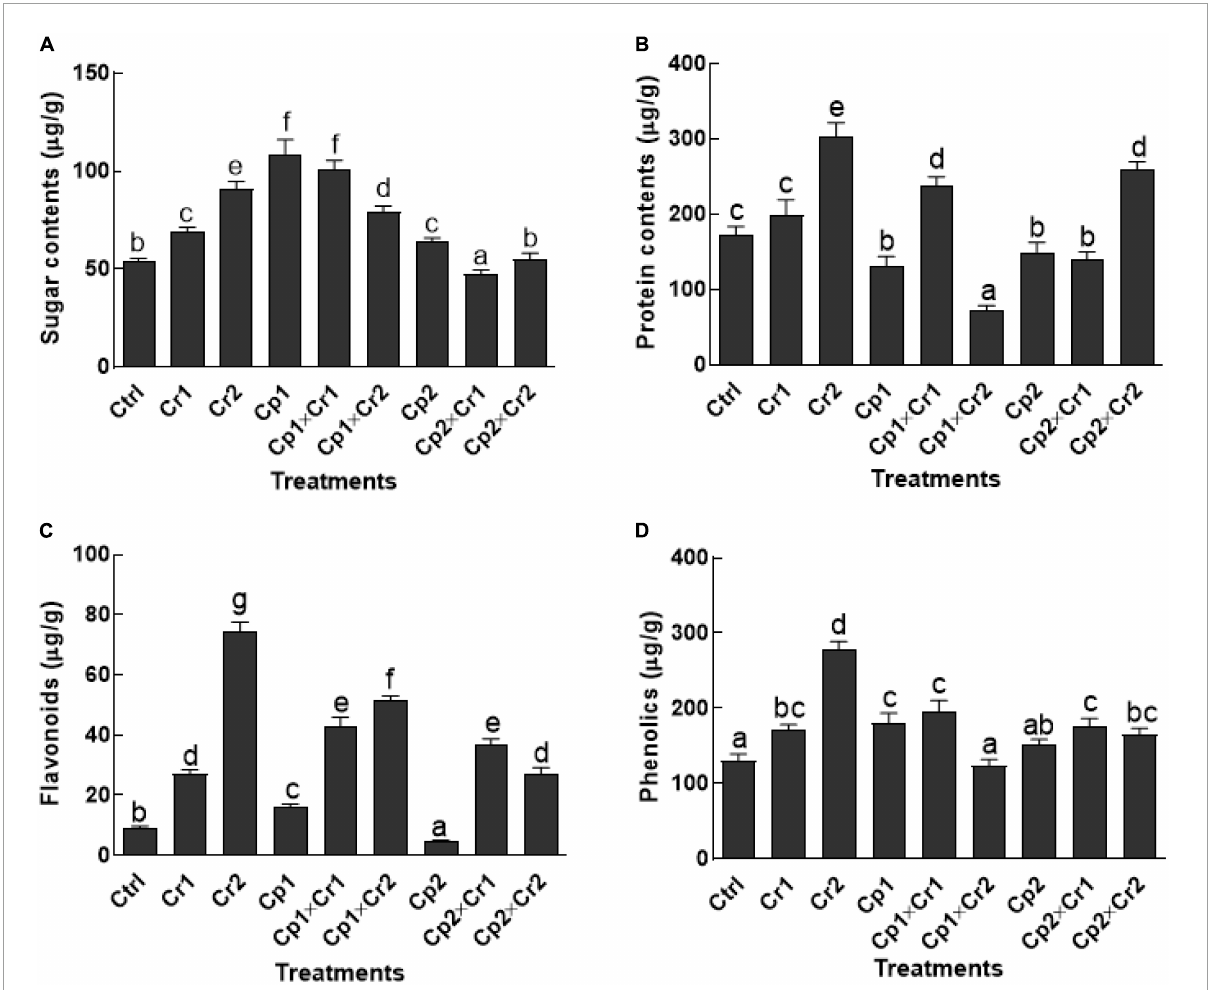
FIGURE2 (A) Sugars; (B) Proteins; (C) Flavonoids; (D) Phenolics of 15-days-old soybean plants after treatment with endophytes Cp1 and Cp2 exposed to Cr stress. Cp1 = Stemphylium lycopersici ; Cp2 = Stemphylium solani ; Ctrl = control; Cr1 = 10 ppm chromium; Cr2 = 50 ppm chromium. Each bar represents mean of triplicated data ( n = 3) with standard error. Bars that are labeled with different letters are significantly different at p < 0.05 computed by Duncan multiple range